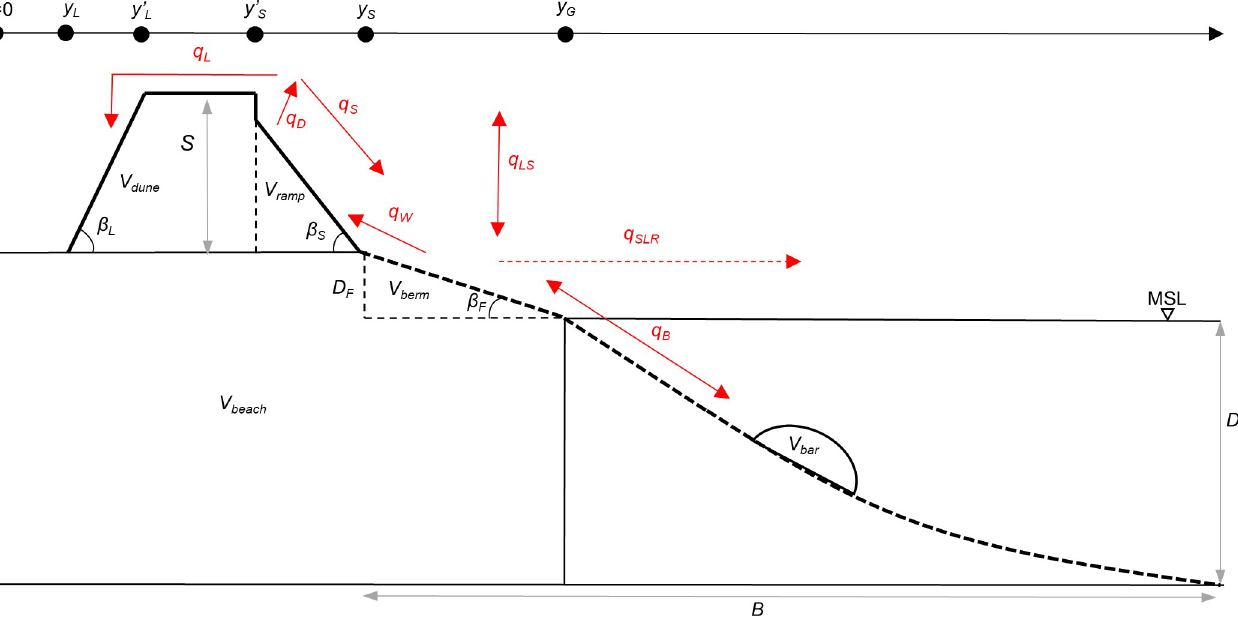
PLOS ONE | https://doi.org/10.1371/journal.pone.0215651 April 19,